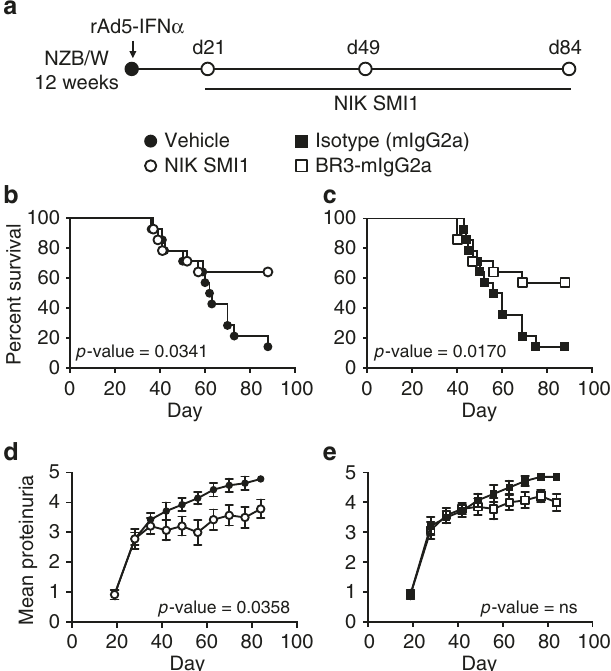
Fig. 7 NIK inhibition improves survival and proteinuria in NZB/W F1 mice. a Experimental design. Lupus prone NZB/W F1 mice were accelerated with adenovirally delivered IFN α and treated with NIK SMI1, BR3-mIgG2a or appropriate controls for 84 days. b , c Kaplan – Meier curves of percent survival when treated with NIK SMI1 ( b ) or BR3-mIgG2a ( c ). d, e Proteinuria scores of mice treated with NIK SMI1 ( d ) or BR3-mIgG2a ( e ). Proteinuria data are represented as mean ± standard error of the mean of 15 mice for each timepoint. For deceased mice, a proteinuria score of 5 was carried forward.